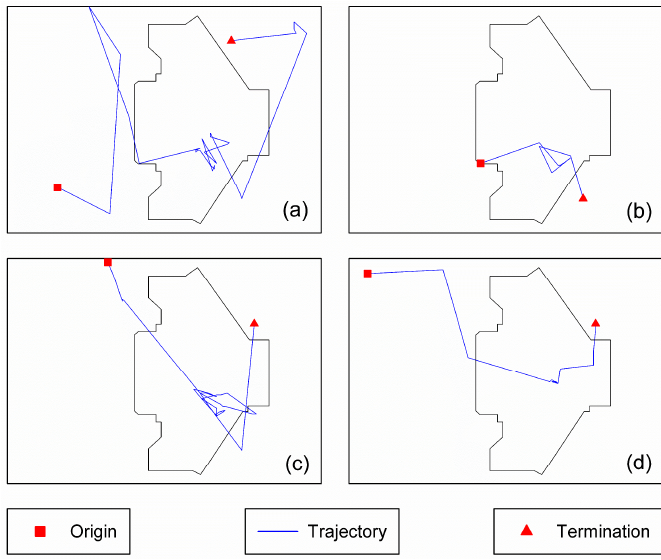
Figure 7. Passenger trajectory examples. ( a ); ( b ); ( c ) and ( d ) show trajectories of four different passengers in the T3-C Entrance. Table 2. Error statistics of different parameter combinations. Parameter Combinations Error